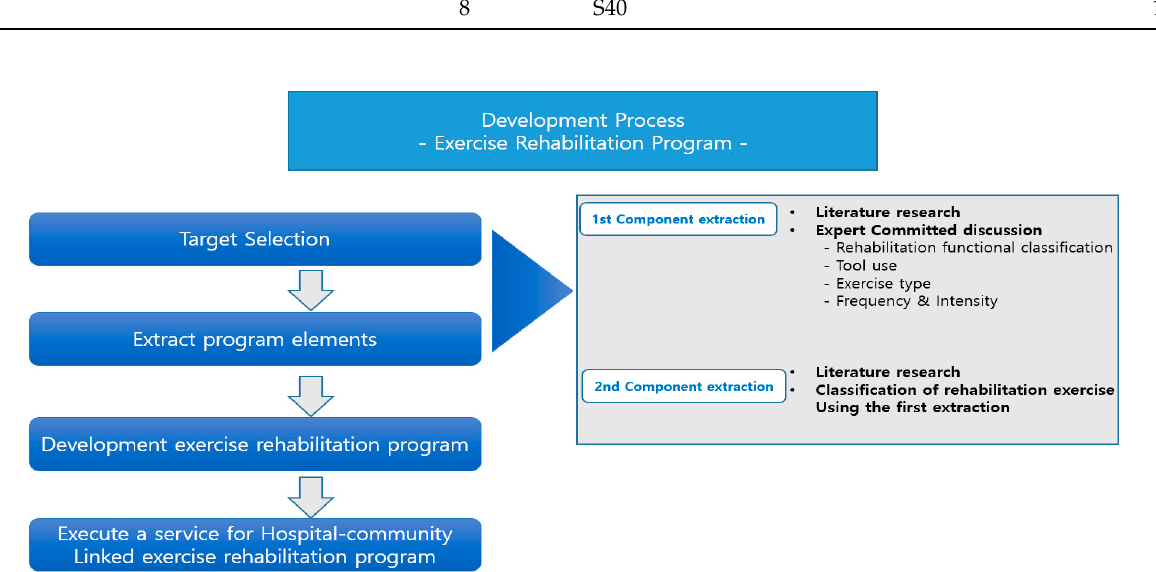
Figure 2. The whole development process—exercise rehabilitation program.